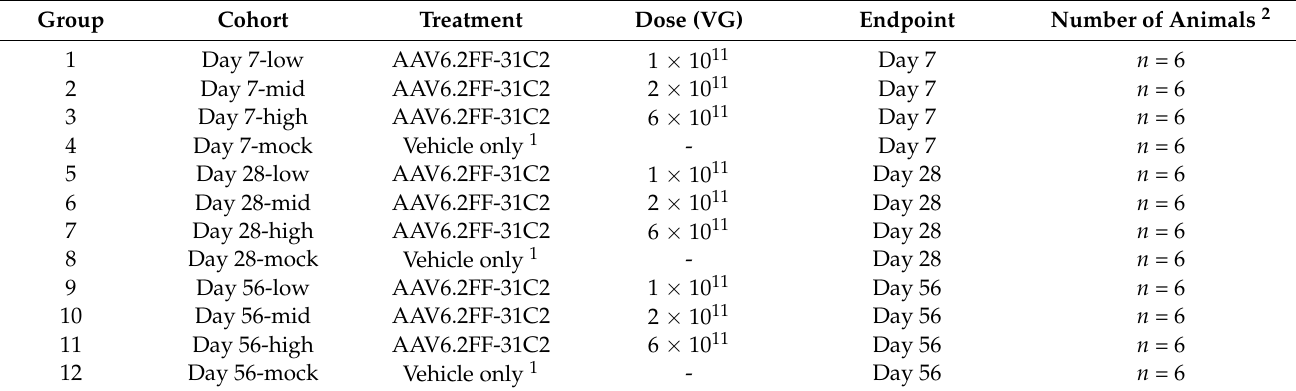
Table 1. Mouse safety and tolerability study design.